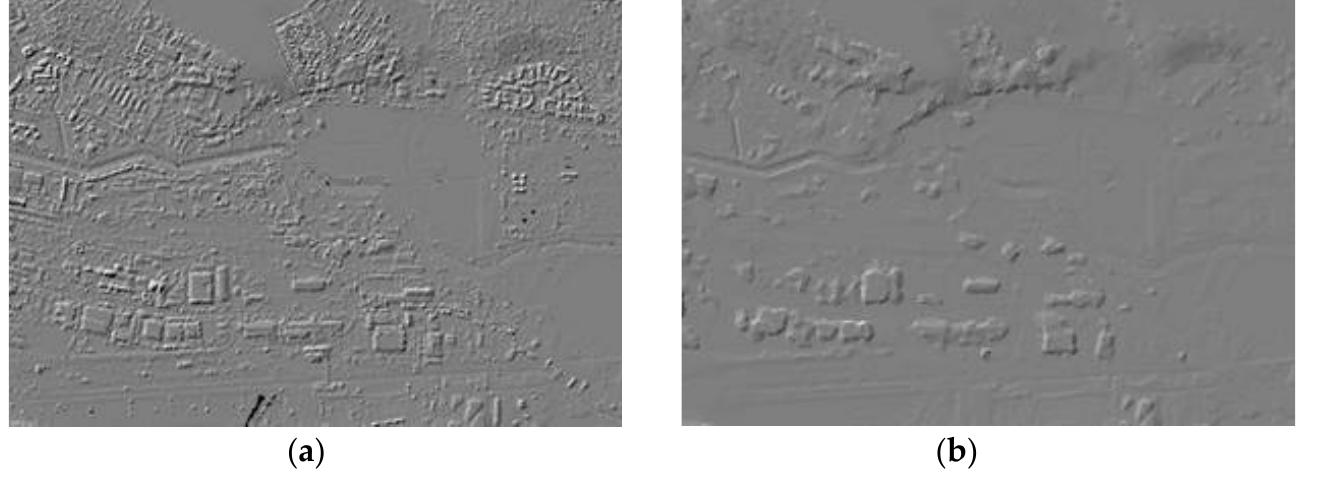
Figure 15. ( a ) Detail of the study area LR ALS-DTM in raster format using moving plane interpolation method (5 m cell size, 20 m search radius, 20 neighbors); ( b ) filtered LR ALS-DTM using the robust filtering method.